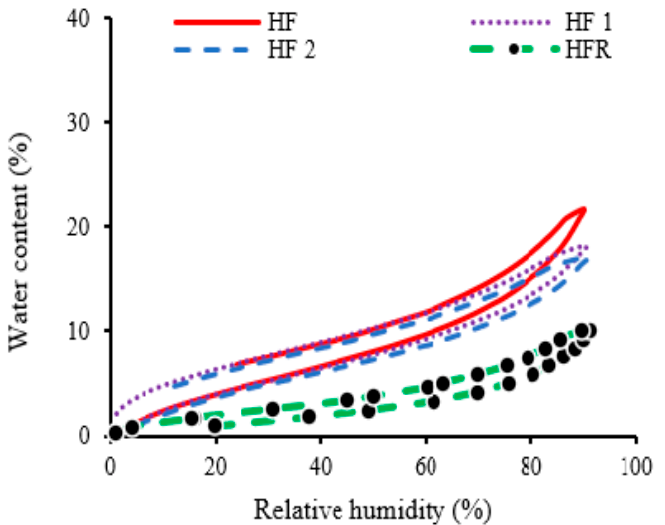
Figure 6. Sorption isotherms of HF fibers. It is worthy to mention the fiber’s abbreviations, as follows: PS/HF corresponds to the raw fibers (i.e., without treatment), PS1/HF1 corresponds to the treated fibers after the first infusion and PS2/HF2 after the second infusion, and PSR/HFR are those impregnated in resign.